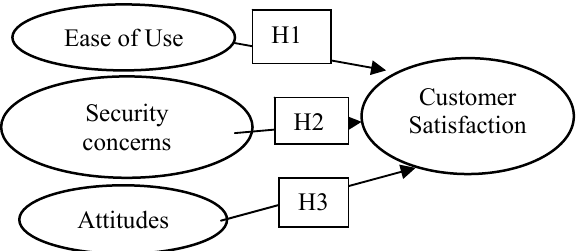
Fig. 1. Proposed factors influencing customer satisfaction with ATM banking services